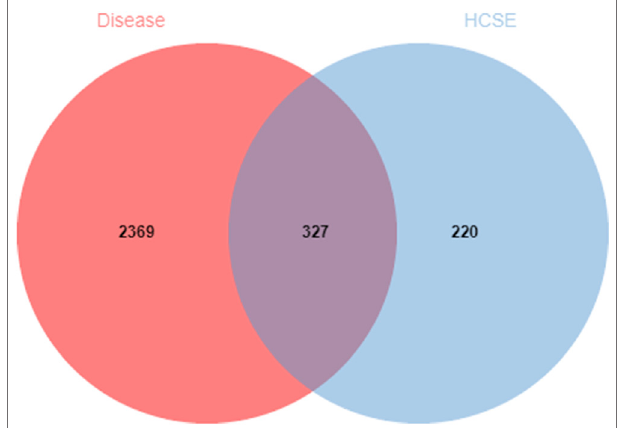
FIGURE 1 | Venn diagram of the overlapping drug and disease target genes. The red circle represents the targets for ischemic stroke with Qi de fi ciency and blood stasis syndrome. The blue circle represents the targets for the new formulation. The 327 overlapping genes are potential therapeutic targets for the new formulation against ischemic stroke with Qi de fi ciency and blood stasis syndrome.